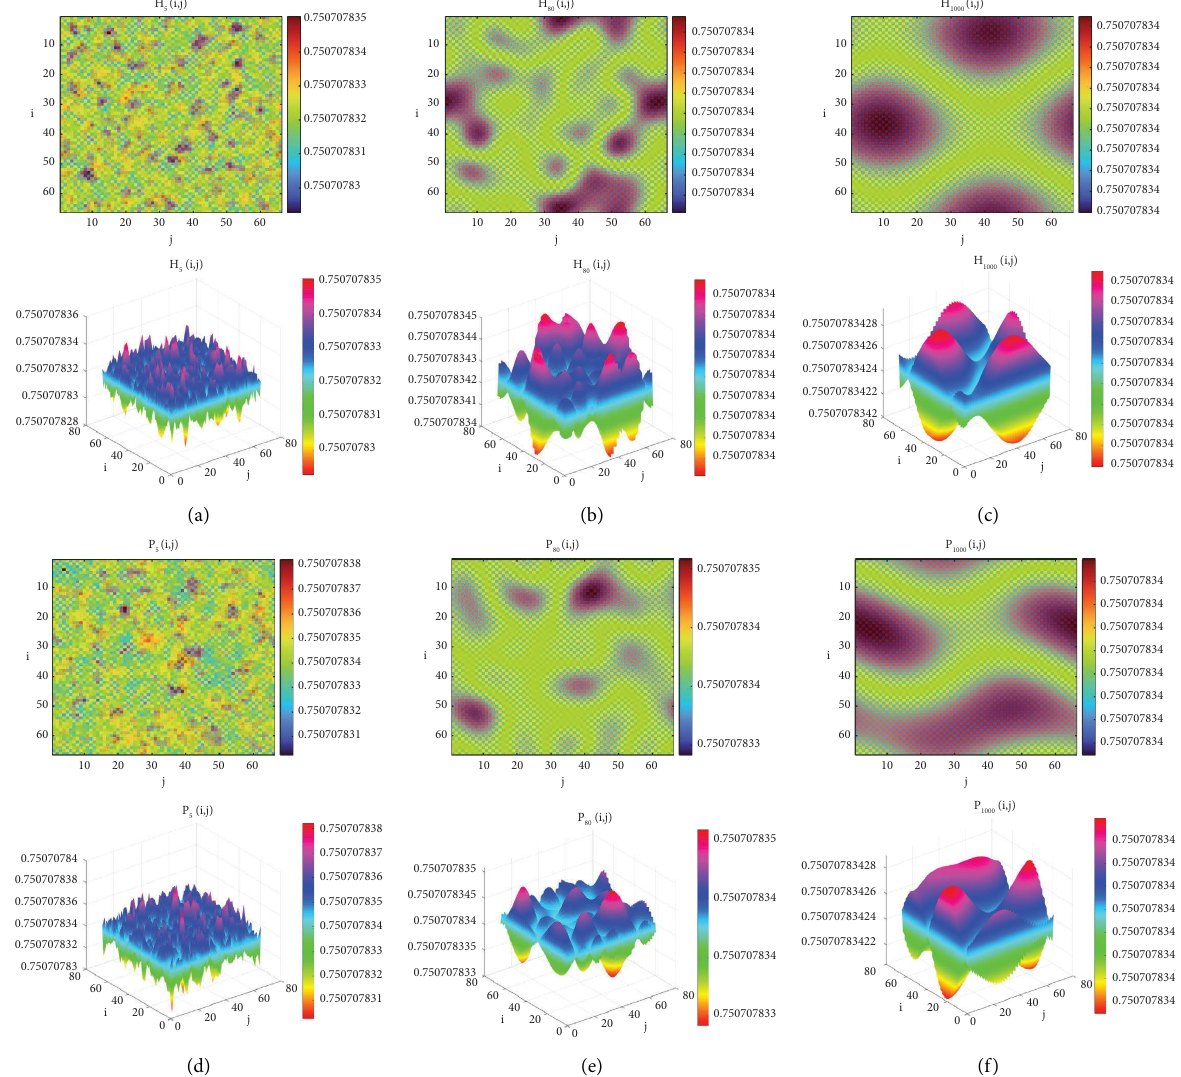
Figure 16: R � 2 , k � 1, c � 0 . 8, σ ∗ � 0 . 278655, σ � 0 . 5, ( d which is consistent with the case of Corollary 3(4), a Neimark-Sacker bifurcation occurs, parasite and host populations exhibit periodic oscillations in two-dimensional